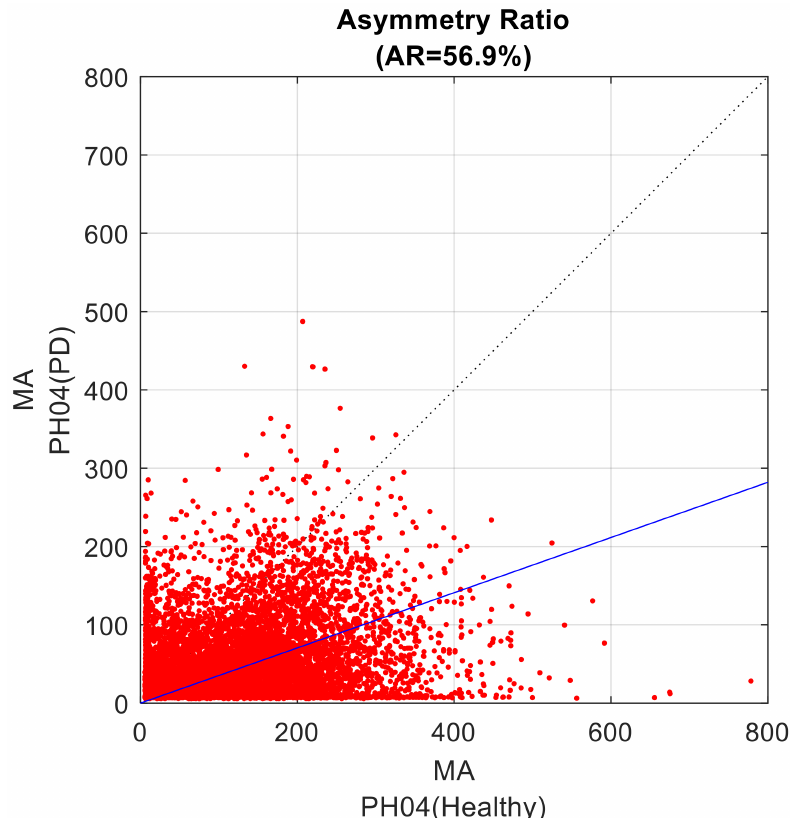
Figure 2. Scatter plot of the two considered MA profiles. The values from the healthy component of the dyad are set to the X-axis; the values of the dyad component with PD are set to the Y-axis. The data cloud best fitting line is presented in blue; the bisect line is the dotted line. The AR value of the present example is